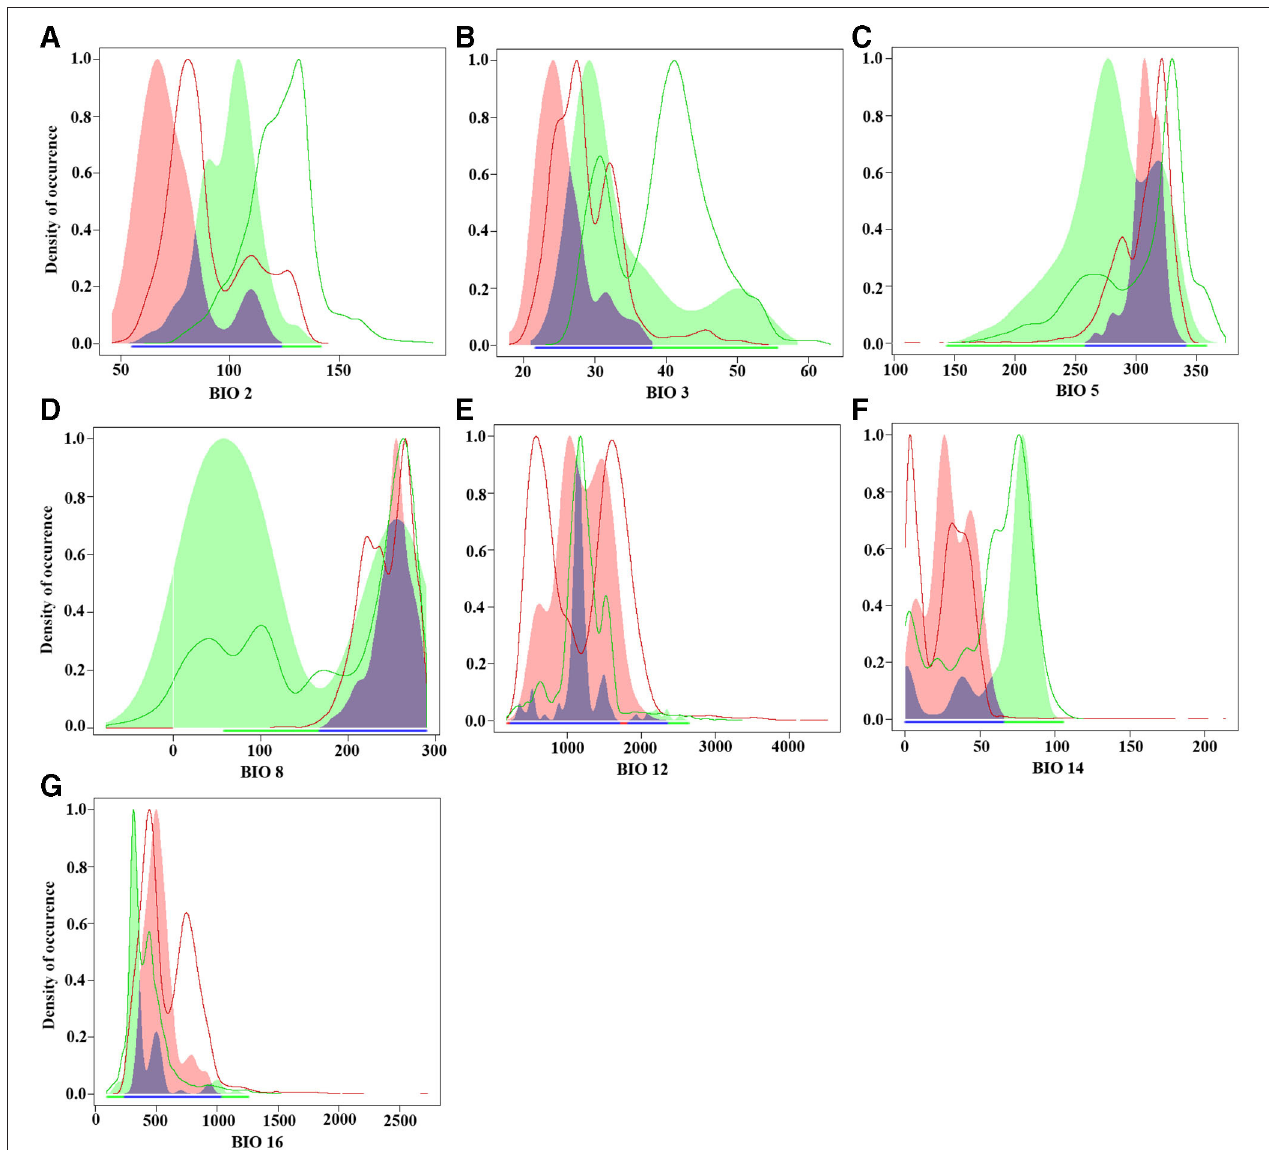
FIGURE 4 | Predicted niche occupancy (PNO) profiles. Blue indicates niche overlap, green represents the origin country, and red represents the invasion country. (A) Mean diurnal range (Bio2); (B) isothermality (Bio3); (C) max temperature of the warmest month (Bio5); (D) mean temperature of the wettest quarter (Bio8); (E) annual precipitation (Bio12); (F) precipitation of the driest month (Bio14); (G) precipitation of the wettest quarter (Bio16).